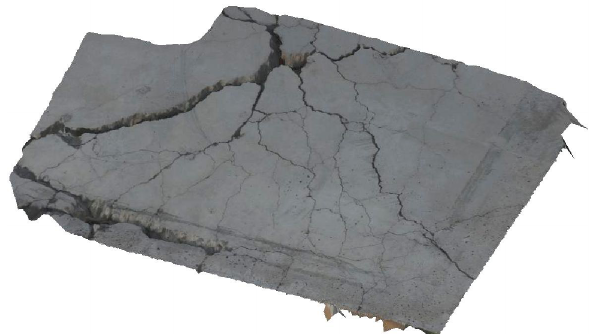
Figure 15. Sparse point cloud of test plate and camera poses using DJI Phantom 4 and Meshroom.